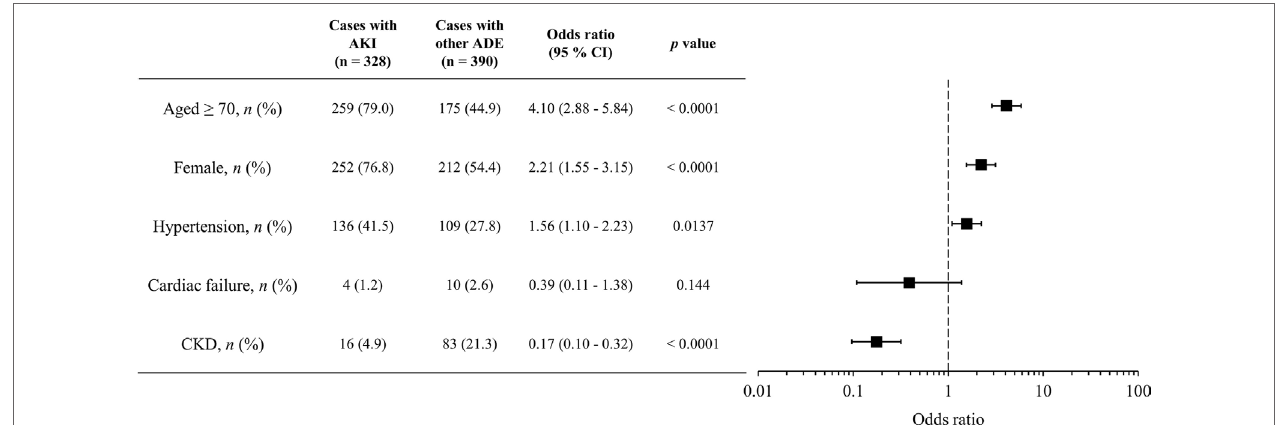
FIGURE 2 | Characteristics of candidate risk factors for AKI with concomitant use of VACV and NSAIDs. Boxes represent odds ratio, and vertical lines represent 95% confidence